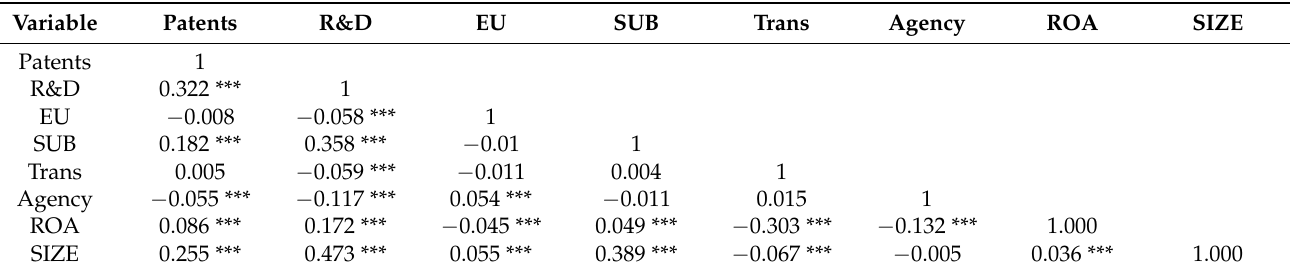
Table 2. Correlation analysis of the main